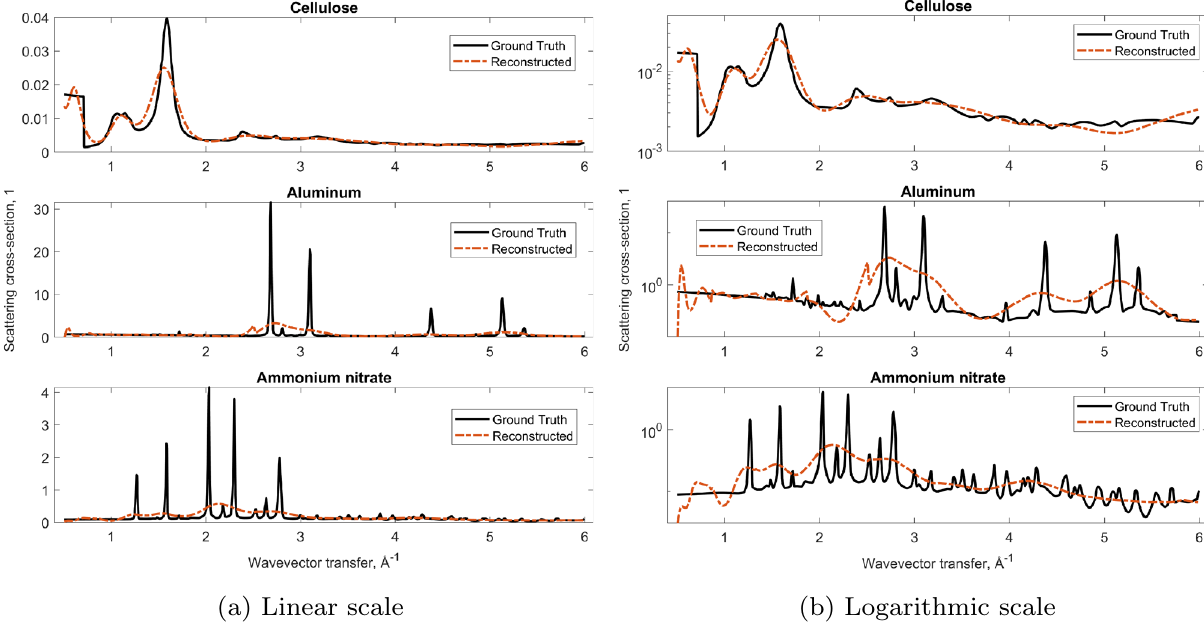
Figure 12. Reconstructed vs ground truth diffraction patterns. Cellulose is an amorphous material, hence its diffraction peaks are very broad and thus easily measured with our low resolution XRD tomography. The other